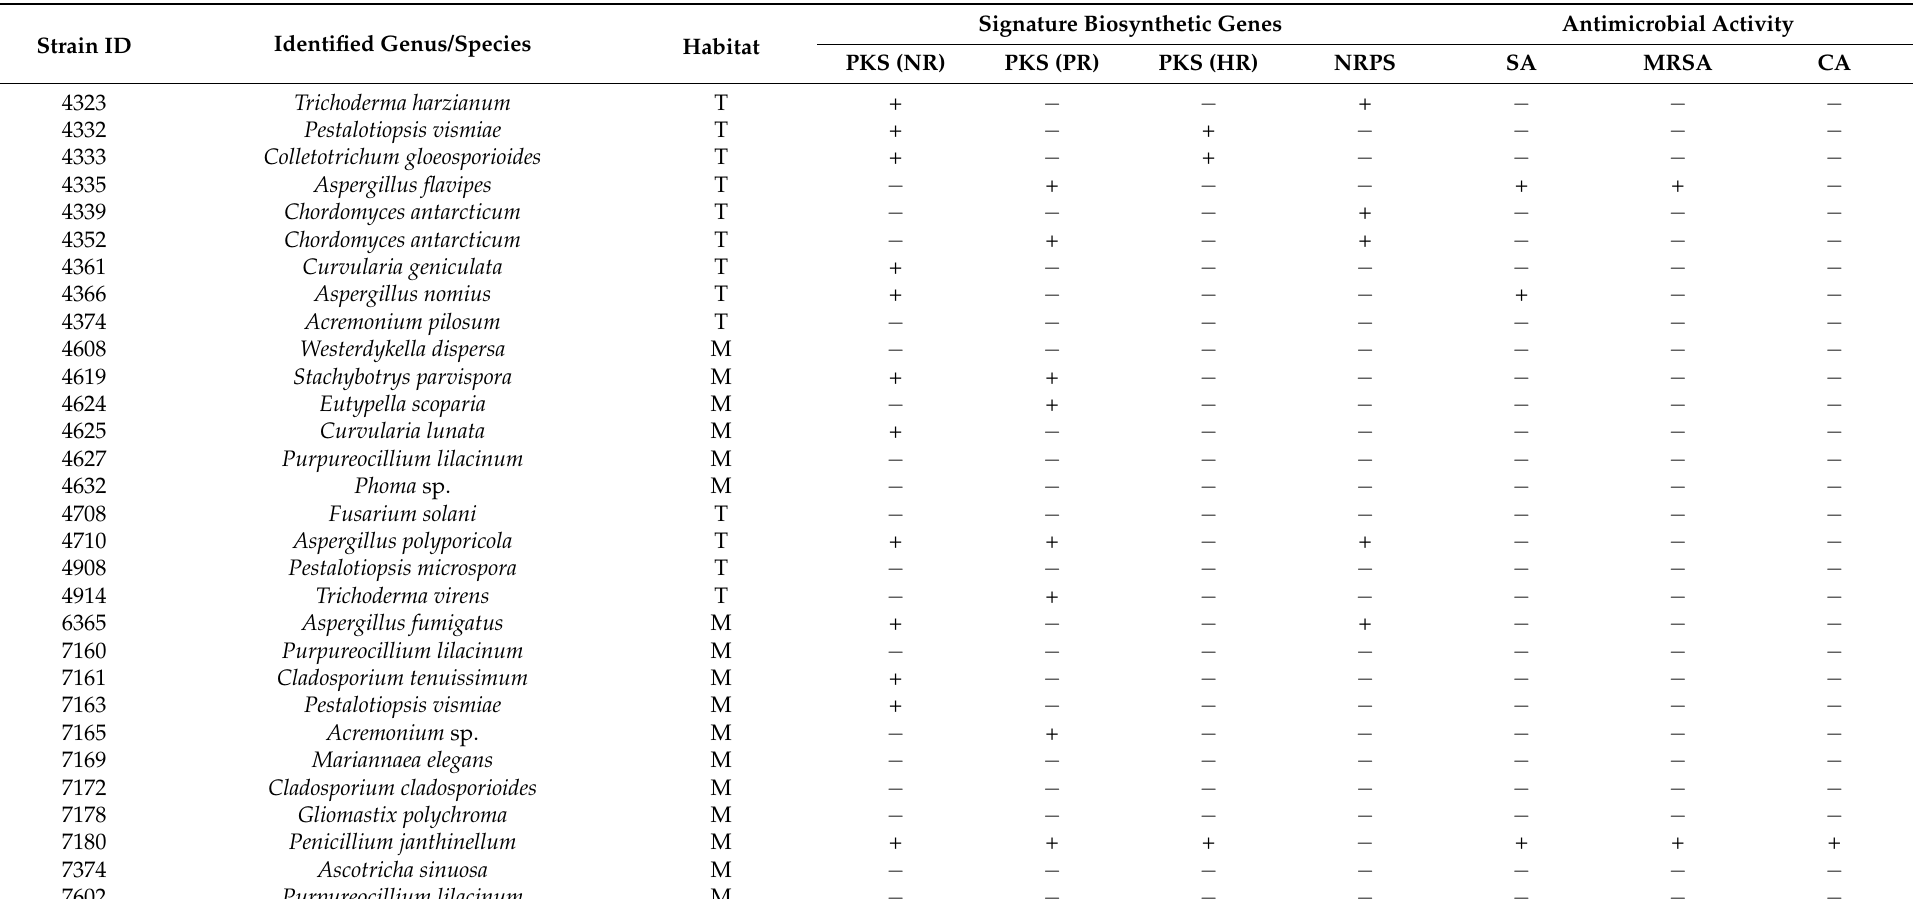
Table 2. Summary of biosynthetic and antimicrobial potential in 30 strains of ascomycetes from St. John’s Island, Singapore. Antimicrobial activity is defined as the ability of crude extracts to inhibit the growth of the test microorganisms by more than 50%. T, terrestrial; M,